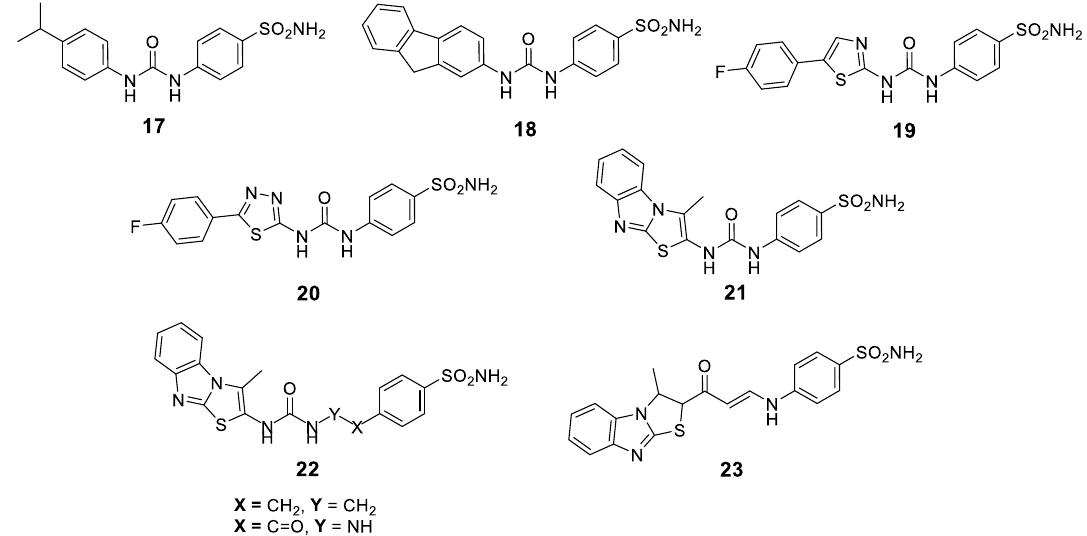
Figure 4. Chemical structures for SLC-0111 analogs ( 17 – 23 ) developed through modification of the SLC-0111 tail.